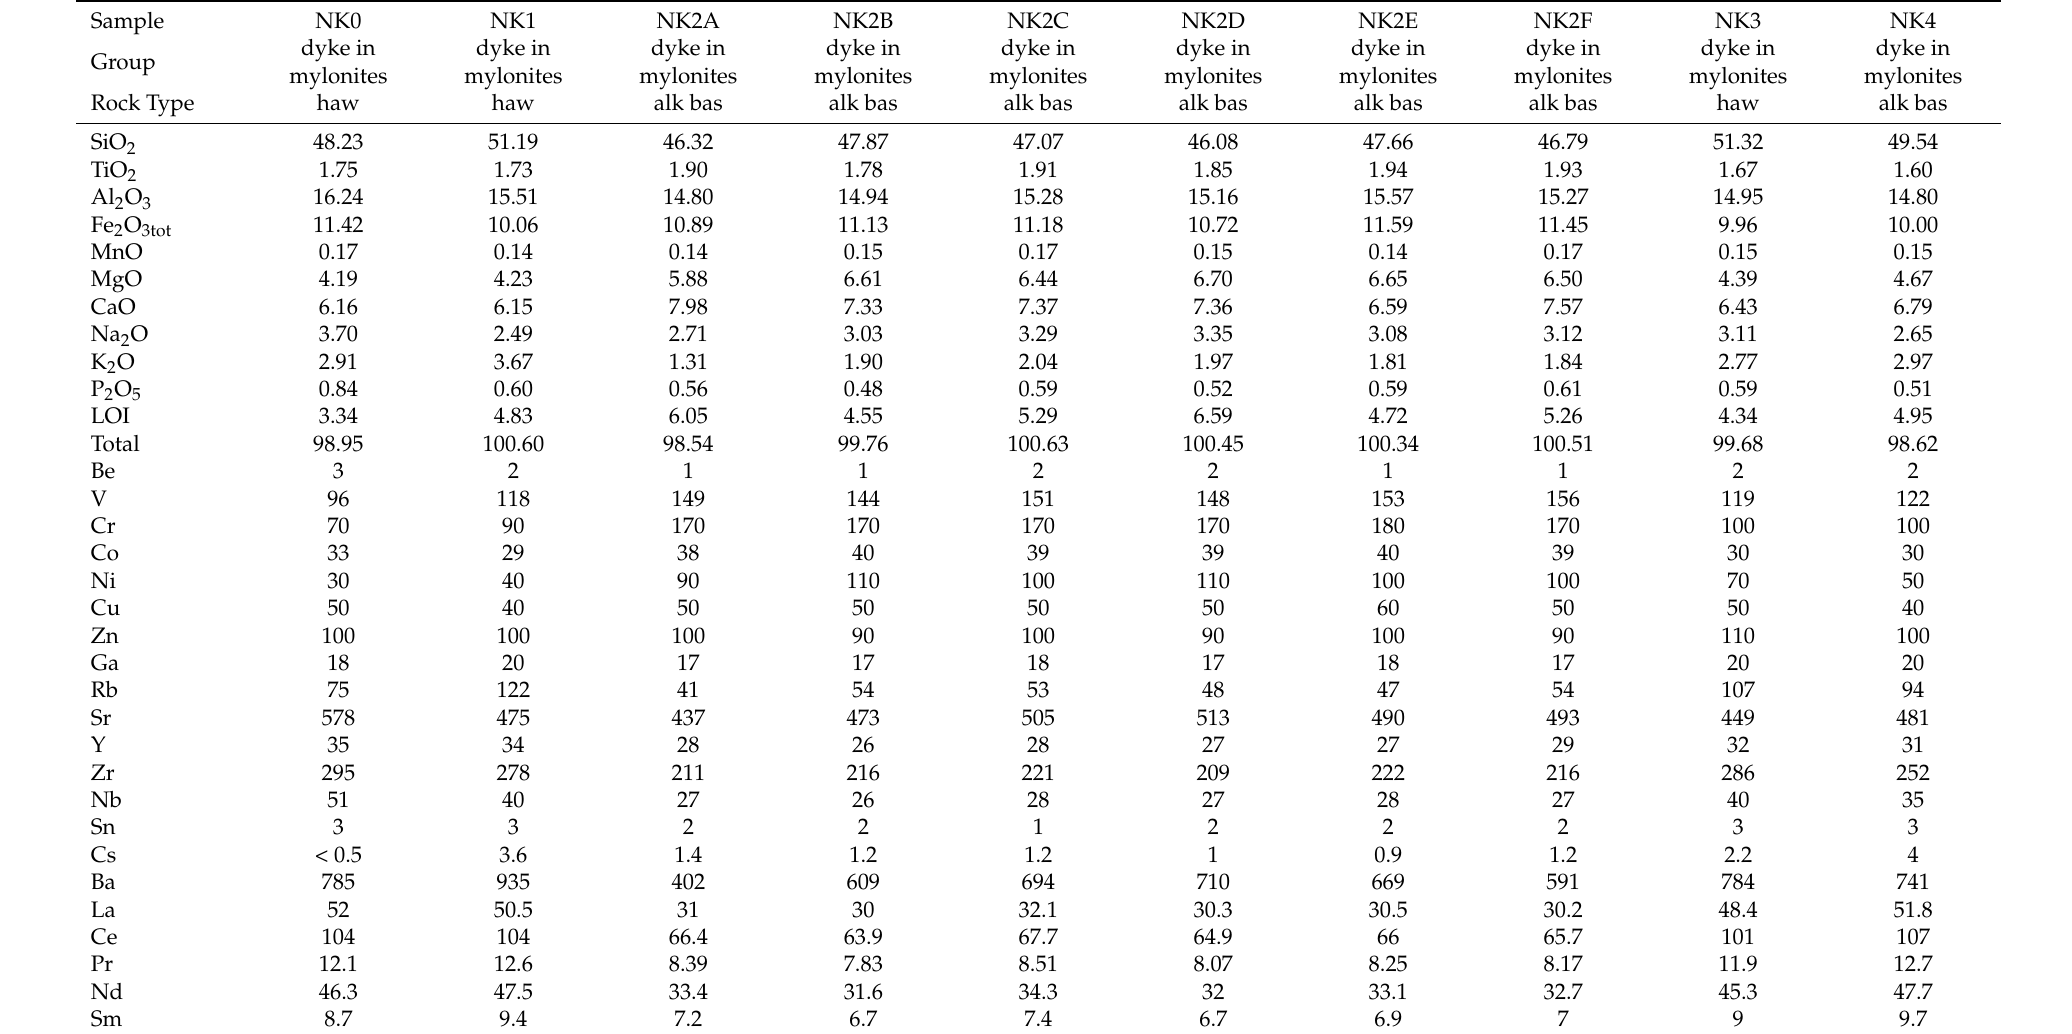
Table 4. Major (wt.%) and trace (ppm) element data for Njimom dykes (western